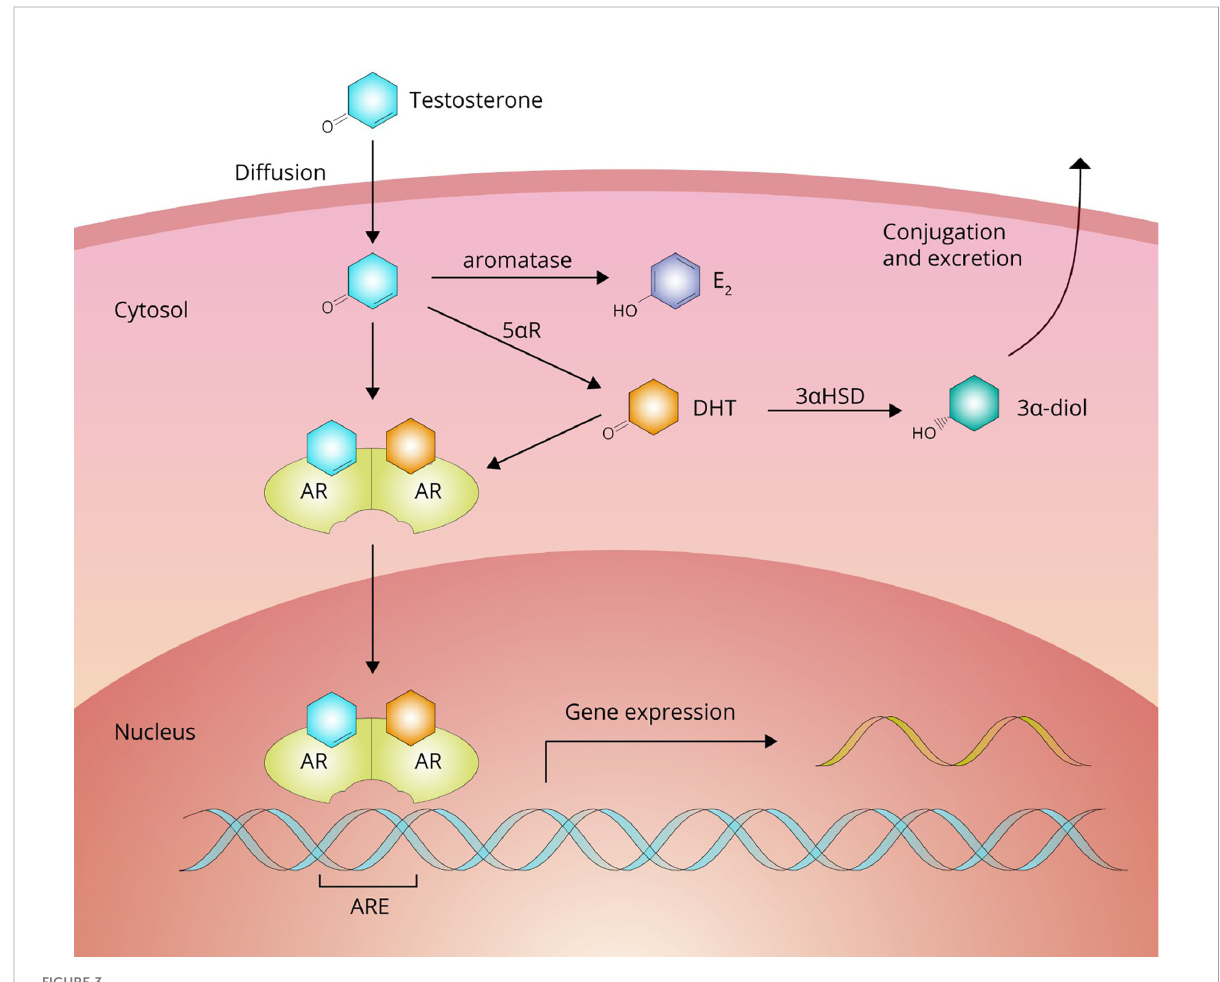
FIGURE 3 Testosterone passes the cell membrane by passive diffusion. Inside the cell, it can either bind directly to the androgen receptor (AR) to affect gene expression or undergo bioactivation into dihydrotestosterone (DHT) by 5 a R-reductase (5 a R) family enzymes or estradiol (E 2 ) by aromatase. DHT can be subsequently inactivated to 3 a -androstanediol (3 a -diol) by 3 a -hydroxysteroid-dehydrogenase (3 a